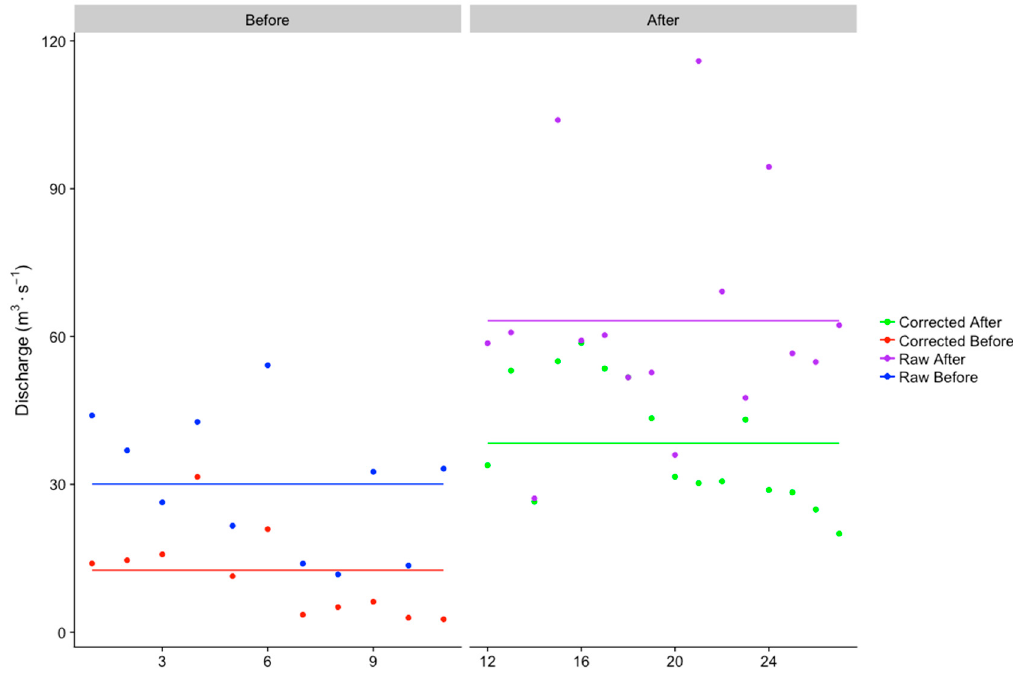
Figure 7. Average winter flow before regulation (year 1–10) for corrected and raw data (red and blue, respectively) and after regulation (year 12–26) for corrected and raw data (green and purple, respectively). The whole lines show the mean of each category of data.